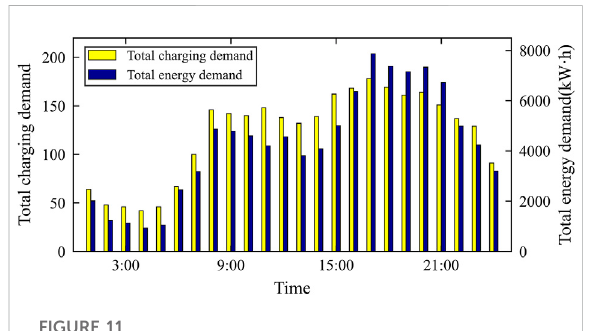
FIGURE 11 Total charging demand and total energy demand statistics by